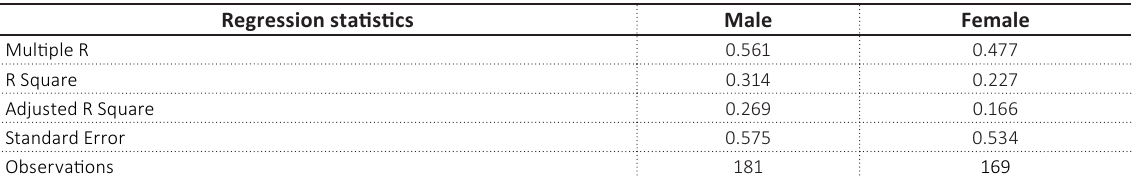
Table 7. Coefficient and p-values of EI components separately for male and female students